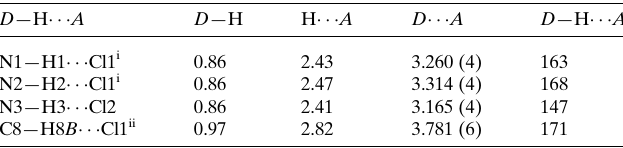
Table 2 Experimental